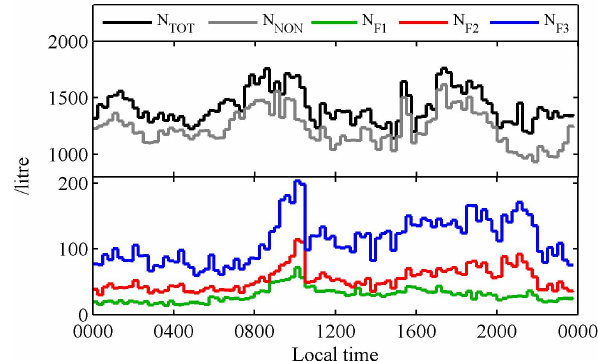
Fig. 3. Diurnal (median) variation in fluorescent, non-fluorescent and total number concentrations in